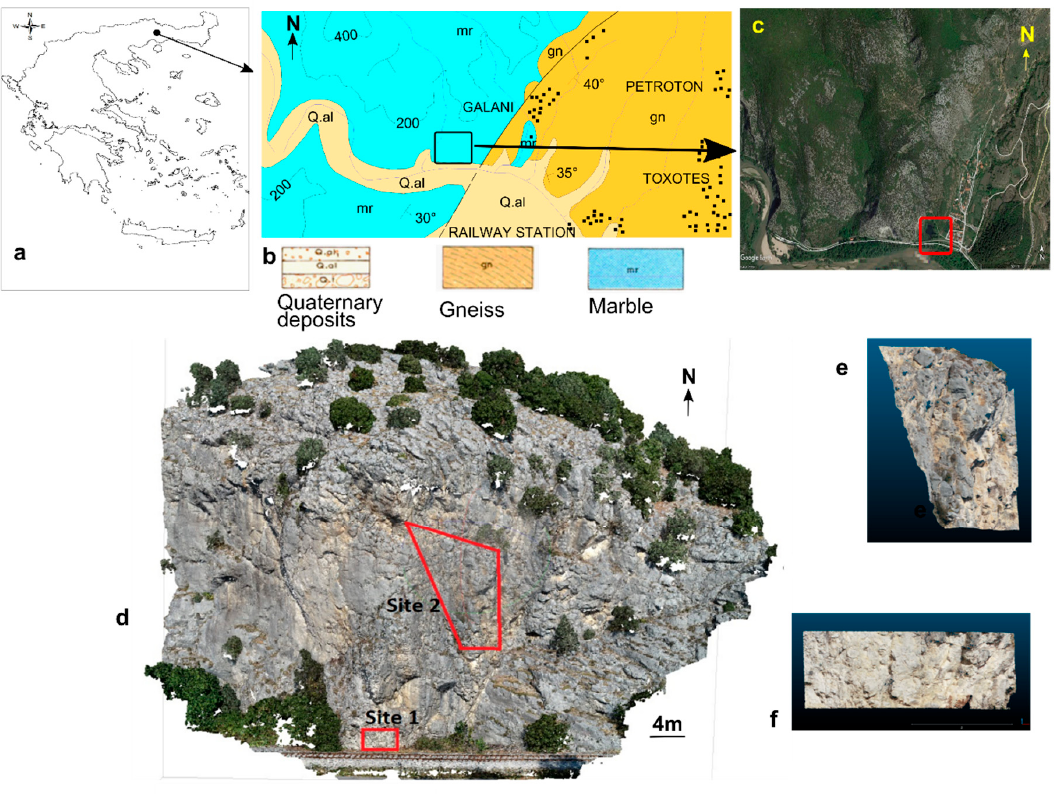
Figure 1. ( a ) Black circle indicates the location of the study area at Northeastern Greece; ( b ) simplified geological map (1:50,000 scale) of the wider area modified by [39], where the study area is defined with a black square; ( c ) red square indicates the location of the study area on aerial imagery (image source: © Google Earth; Digital Globe 2020); ( d ) perspective view of the slope, ( e ) generated 3D point cloud of site 2, ( f ) and generated 3D point view of site 1.